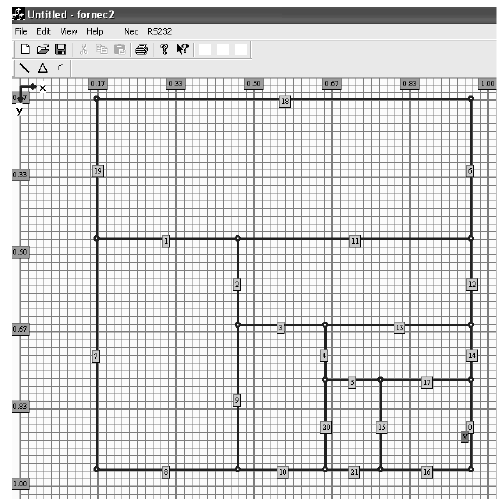
Figure 2. The main window of an application.